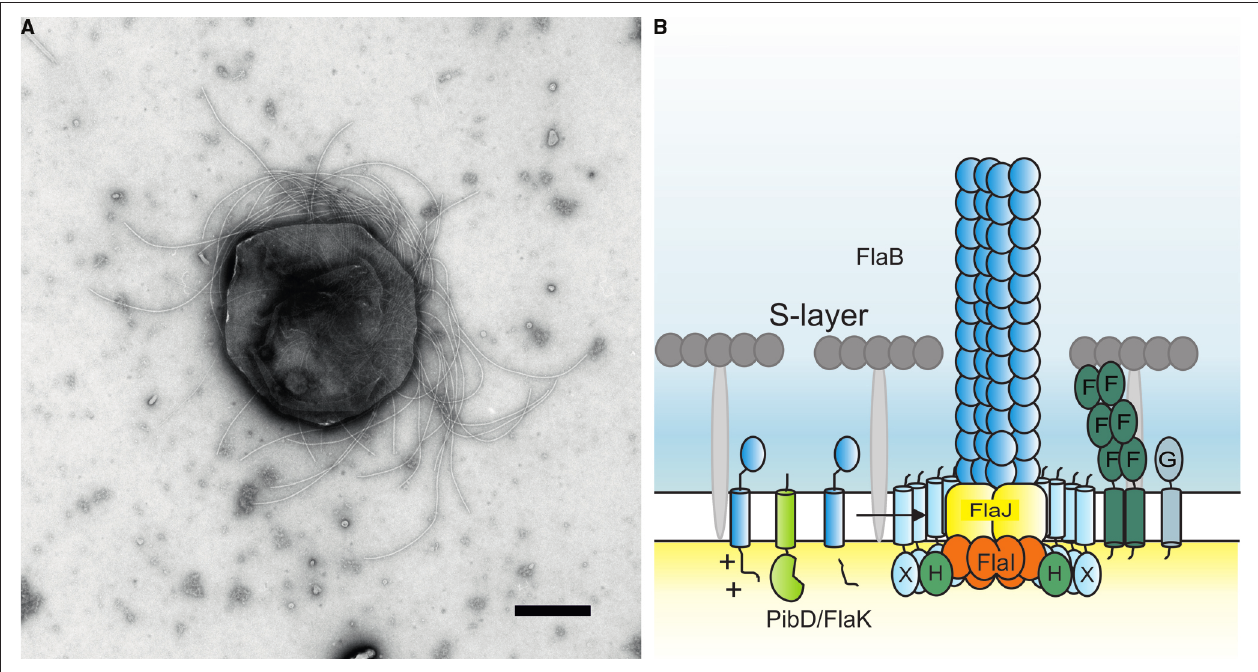
the ring-forming scaffold protein FlaX in which FlaH and FlaI interact most probably with the integral membrane protein FlaJ. The dimeric soluble domain of FlaF interacts with the S-layer. FlaG most probably has a similar function as FlaF as it’s soluble domain has homologies to the one from